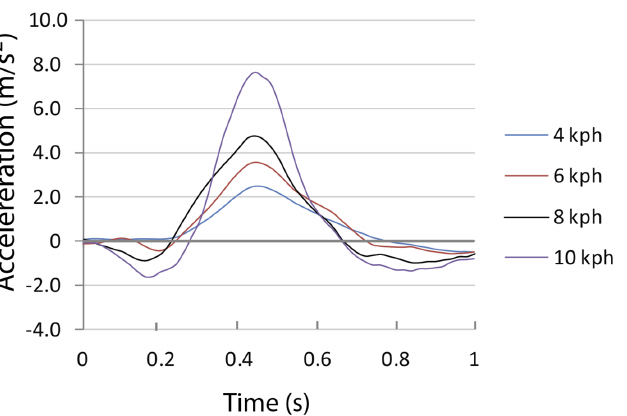
Fig 8. Estimated acceleration in direction of travel at different speeds for one Steller sea lion (F97SI). Averaged from 10 strokes